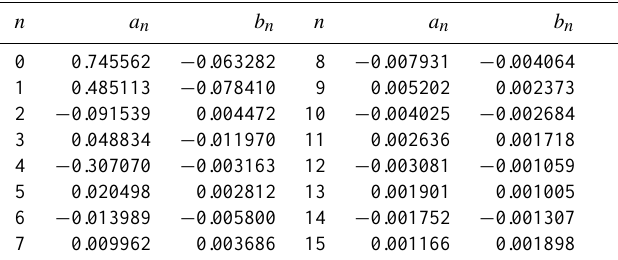
Table 1. Coefficients used for fitting the experimental ripple shapes in experiments of van der Werf et al. (2007) using Eq.